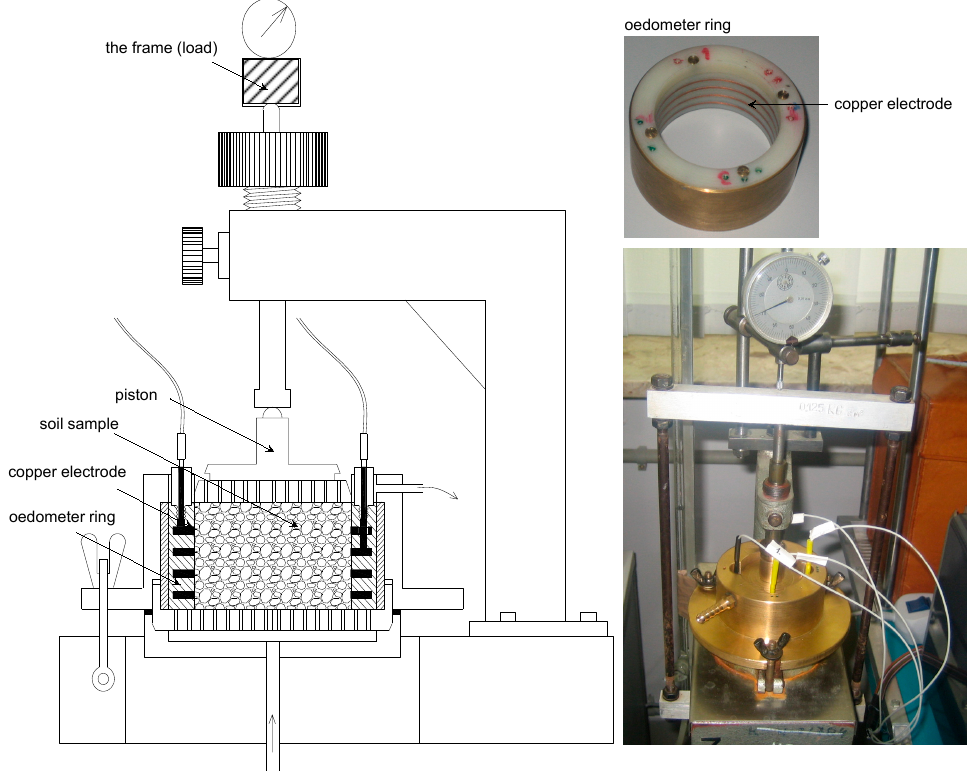
Figure 6. A modified oedometer for measuring electrical resistivity of clayey soils; scheme of apparatus and view of oedometer ring with electrodes and apparatus during the test.